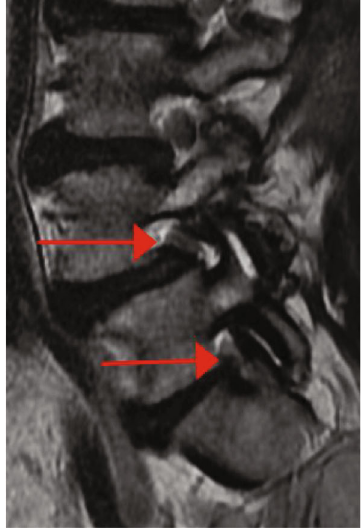
Figure 2: Preoperative T2 sagittal MRI demonstrating spondylolisthesis at L4-5 and foraminal stenosis at both L4-5 and